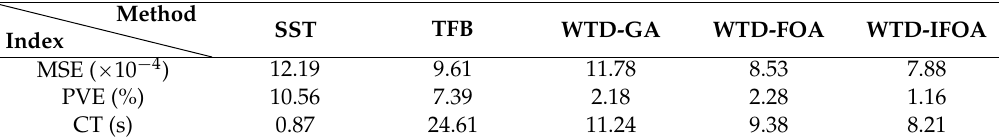
Table 2. Comparison of the five methods (SNR = 5